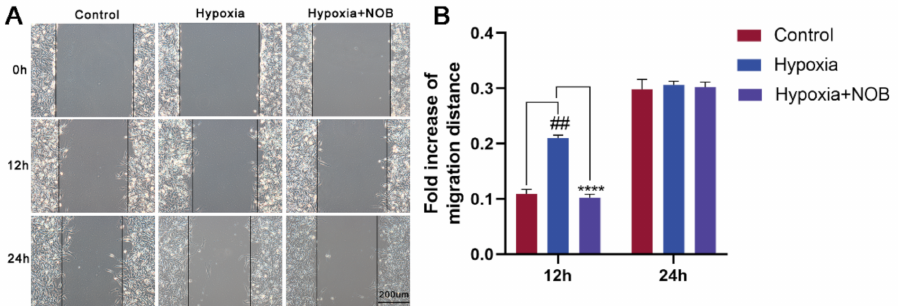
Figure 2. NOB inhibits hypoxia-induced astrocyte migration in scratch wound healing assay. ( A ) The images of wound healing at 0, 12 and 24 h in different groups. Scale bar, 200 µ m. ( B ) Statistical analysis of migration area. The data are expressed as mean ± SD, n = 3. ## p < 0.01 vs. control, **** p < 0.0001 vs. hypoxia group.